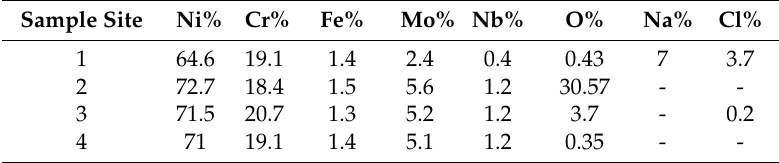
Table 10. The weight percentage of Inconel 625 sample cross section after 2500 h